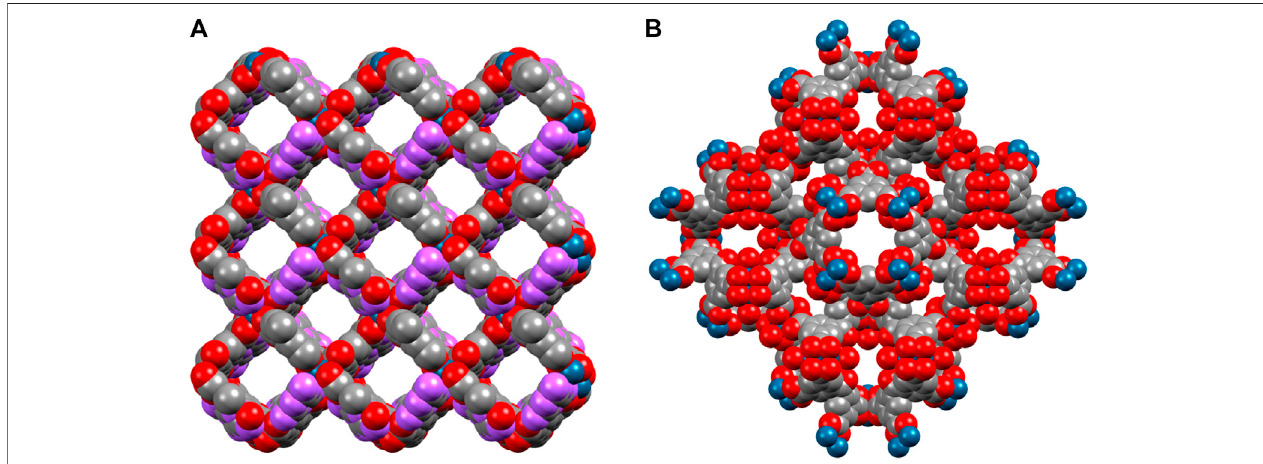
FIGURE 5 | Perspective view of the channels and cages formed within the three-dimensional skeleton of (A) ZnMOF for drug release by Xiao-Tao Xin and Jia-Ze Cheng, 2018 (Xin and Cheng, 2018); (B) ZnMOF for drug release and anticancer activity by Xiao-Ming Han, 2020 (Peng et al., 2020).